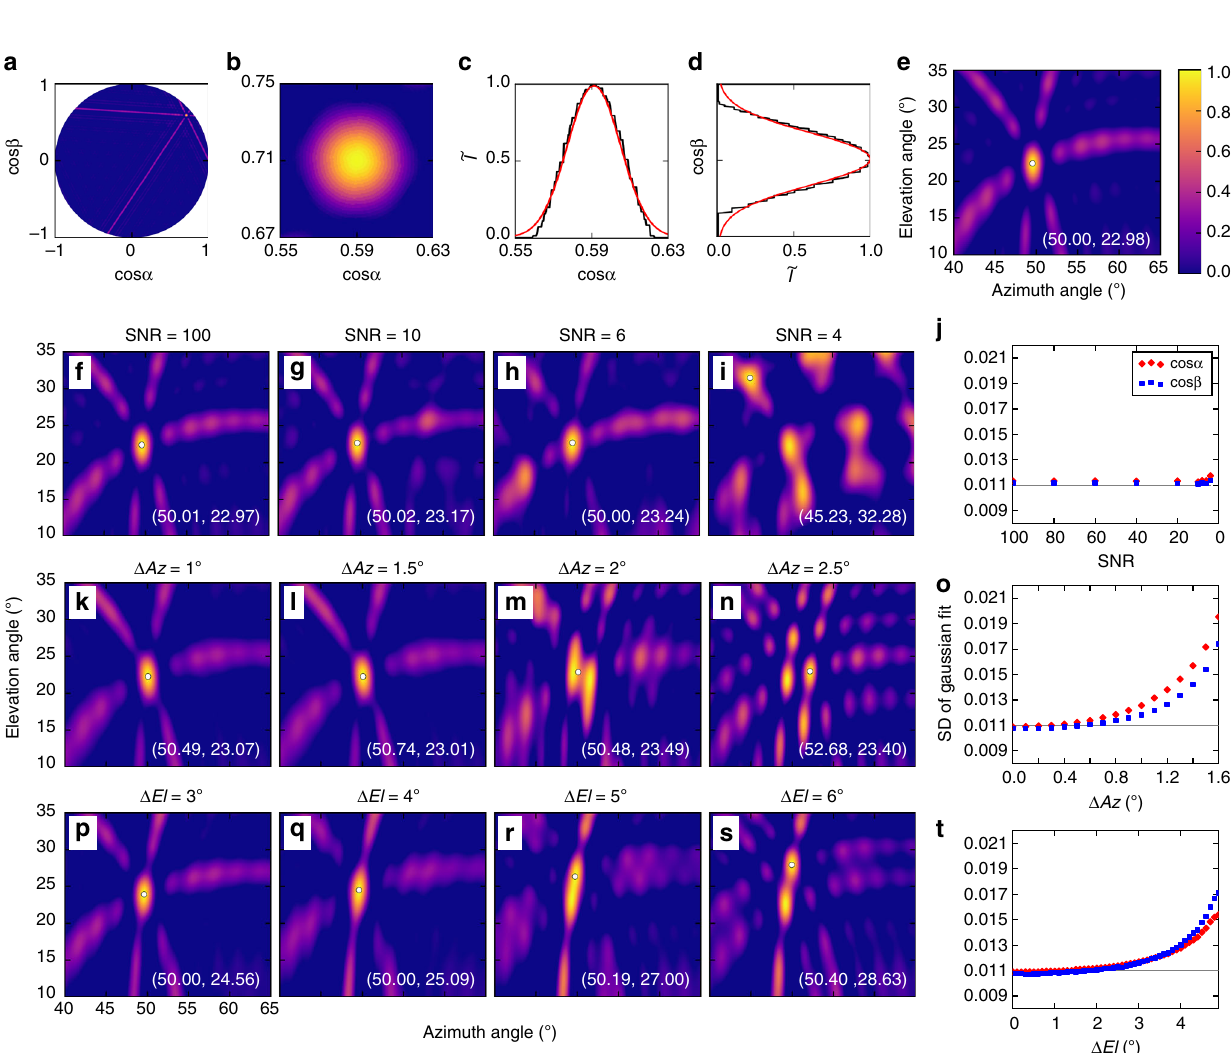
constrain the source to lie along straight lines in the direction cosine plane, each of which is oriented perpendicular to its respective antenna baseline. The location of the source corresponds to the intersection of the lines. The example shown in Fig. 7a is for a point source at the location of NBE 2. For NBE 2, (cos α , cos β ) =